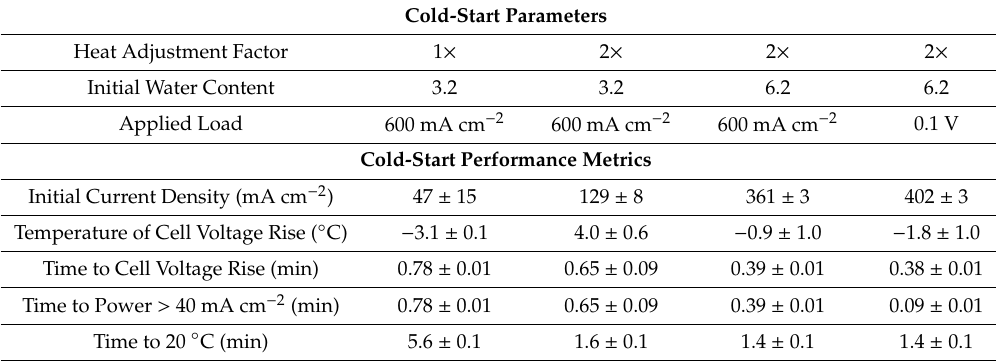
Table 3. Cold-start parameters used in tests from Figure 6 and corresponding select performance